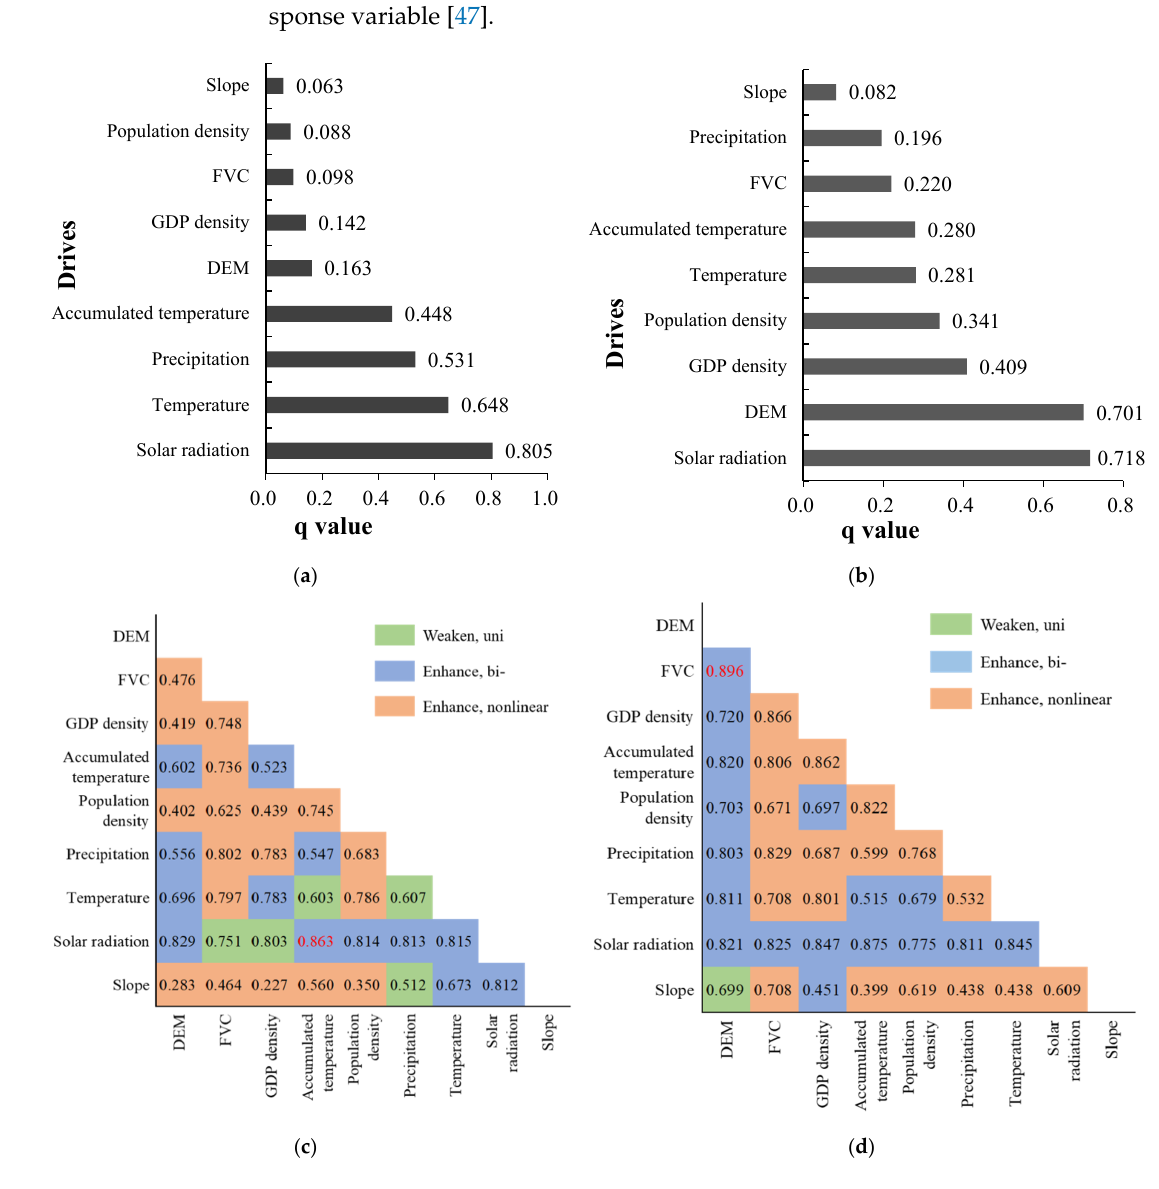
Figure 12. The dominant factors of the change in wetlands. ( a ) Natural wetland; ( b ) Artificial wetland. The dominant interaction factors of the change in wetlands. ( c ) Natural wetlands; ( d ) Artificial wetlands.